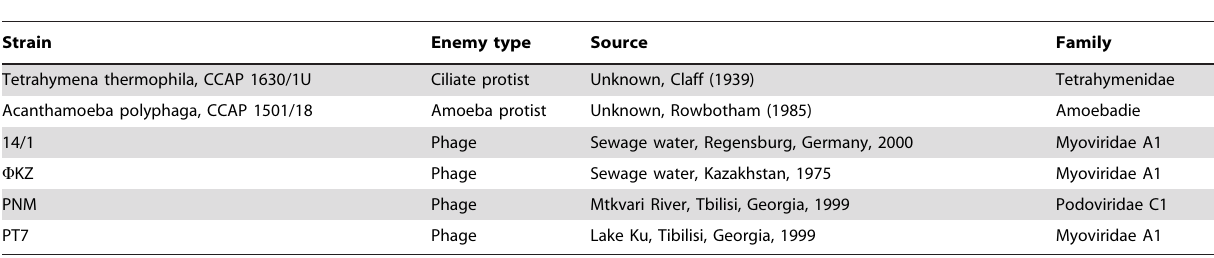
Table 2. Protist and phage species used in this